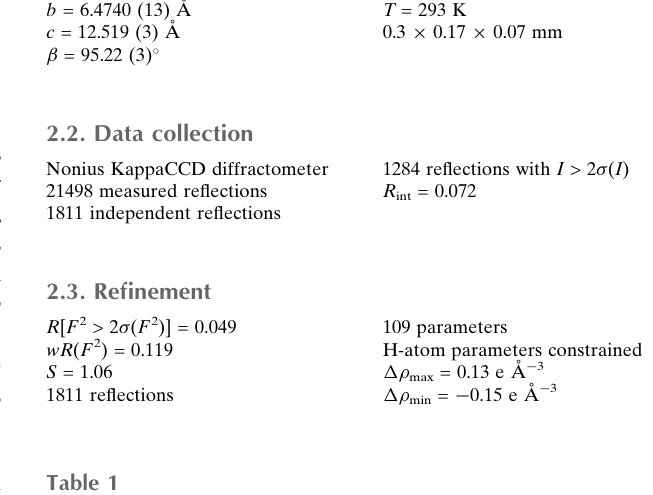
Hydrogen-bond geometry (A˚ , (cid:2)